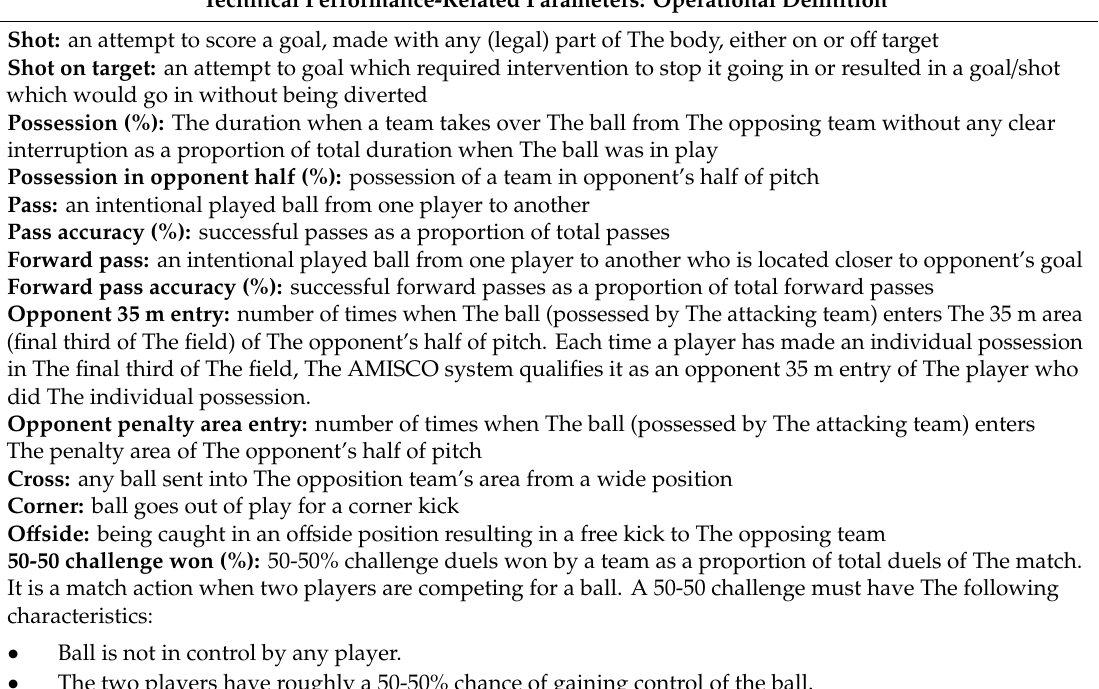
Table 1. Selected technical and physical performance-related parameters (dependent variables). Technical Performance-Related Parameters: Operational